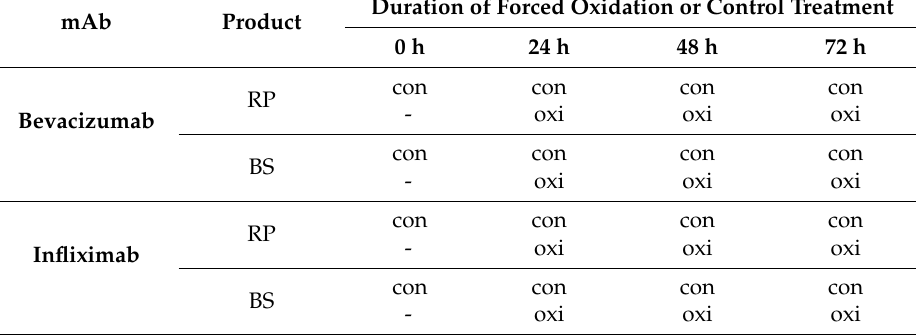
Table 1. Overview of experiments. The reference product (RP) and biosimilar (BS) version of two mAbs (bevacizumab and infliximab) were subjected to forced oxidation (oxi) and control (con) treatment. Each experiment was performed as independent